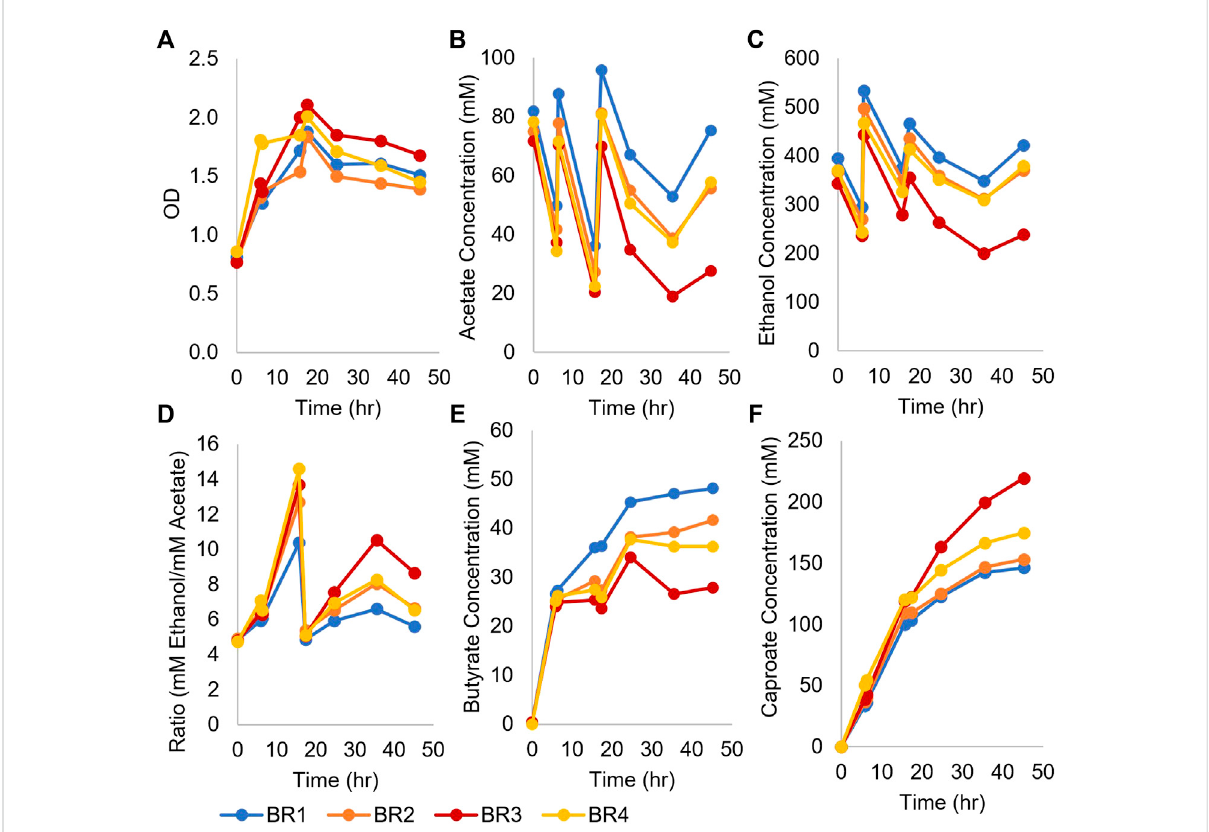
FIGURE 2 Growth and metabolite pro fi les of four Ckl cultures in pH-controlled bioreactors. The OD 600 values remained high throughout the fermentation. OD 600 can be converted to mgCDW/mL by multiplying the OD 600 by 0.43. (A) . Ethanol and acetate were added twice at t = 6 and t = 16 h (B,C) . The ethanol/acetate ratio remained > 4 throughout the fermentation (D) and butyrate concentrations were far lower than caproate concentrations (E) . Note that the culture with the lowest ethanol and butyrate concentrations had the highest caproate titer (F) , 219 mM. The positive slopes in (F) indicate continued caproate